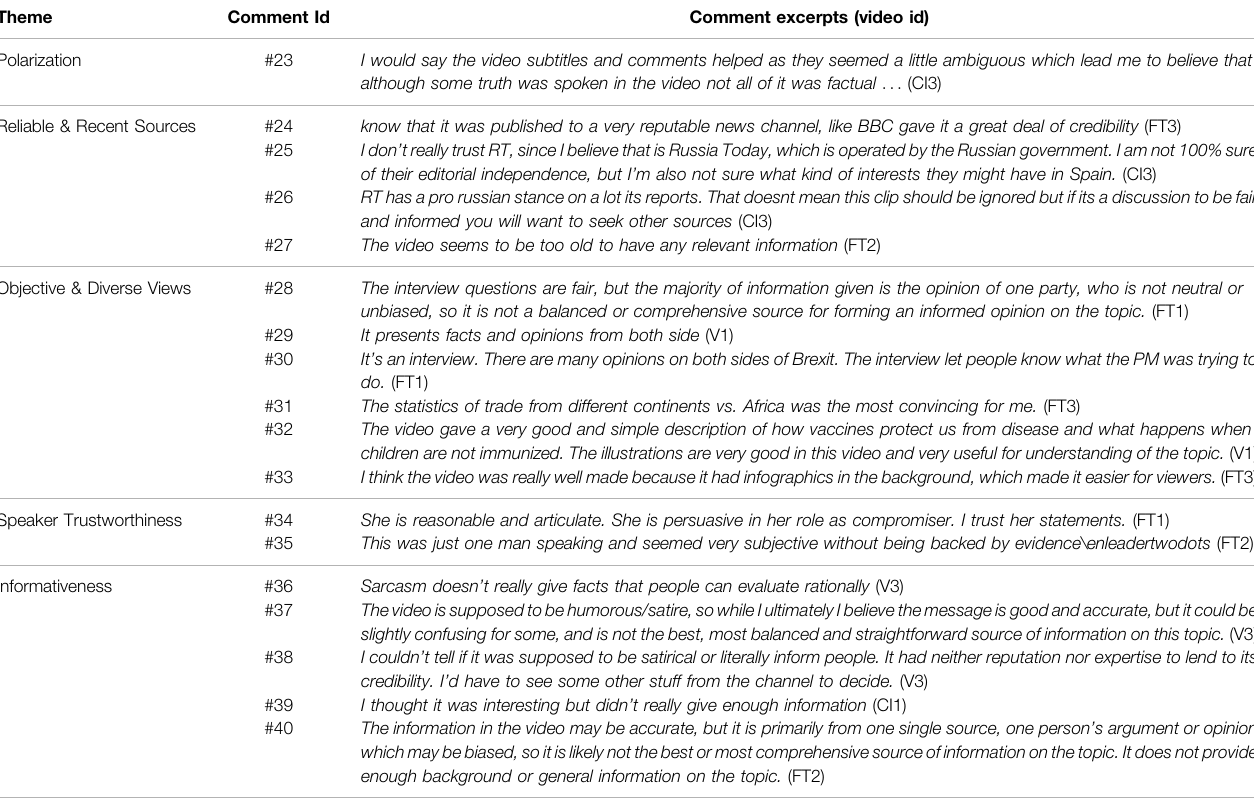
TABLE 8 | Example of general comments given by participants at the end of each study